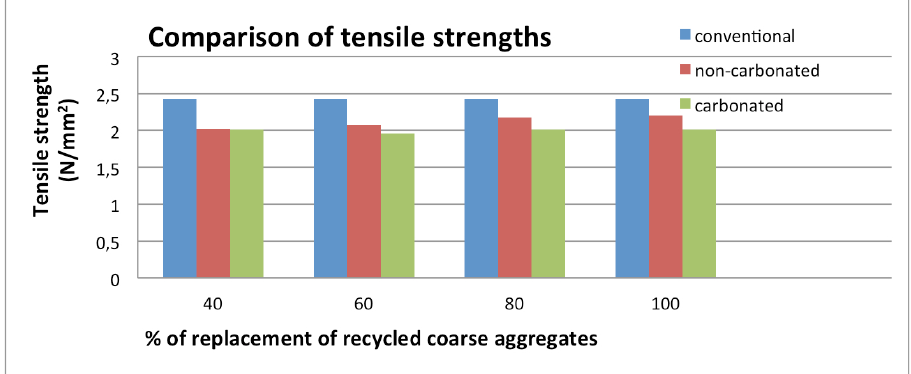
Fig. 7. Comparison of tensile strength non-carbonated and carbonated RAC with conventional